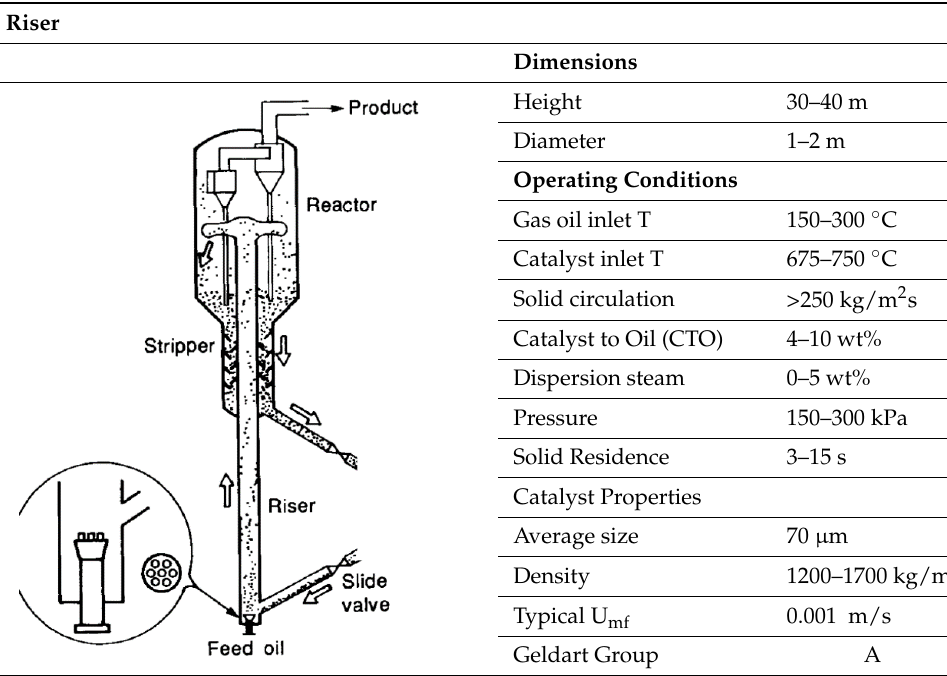
Table 1. Dimensions and operating conditions of fluid catalytic cracking (FCC) unit, [1,5,7,32,33].